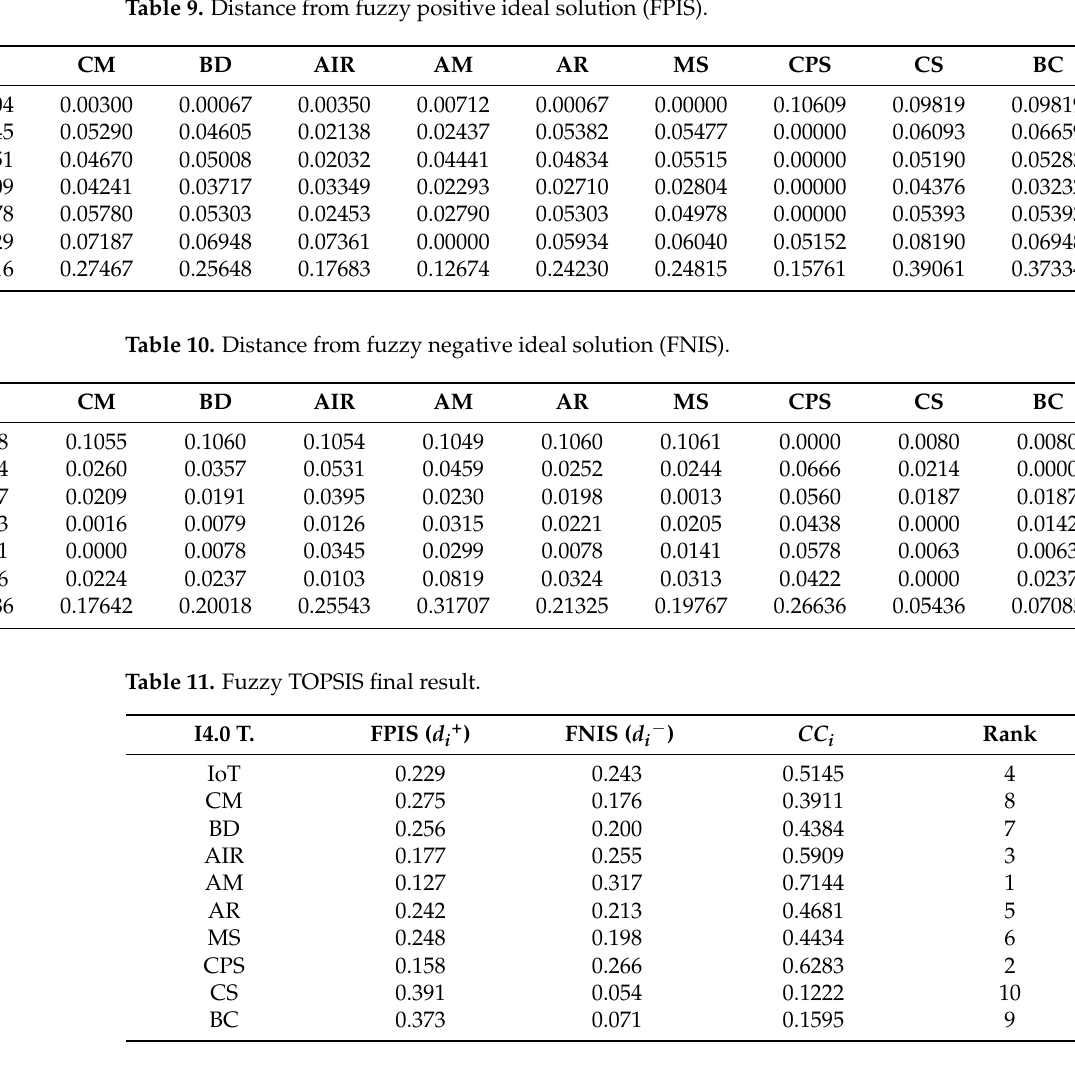
Table 9. Distance from fuzzy positive ideal solution (FPIS).